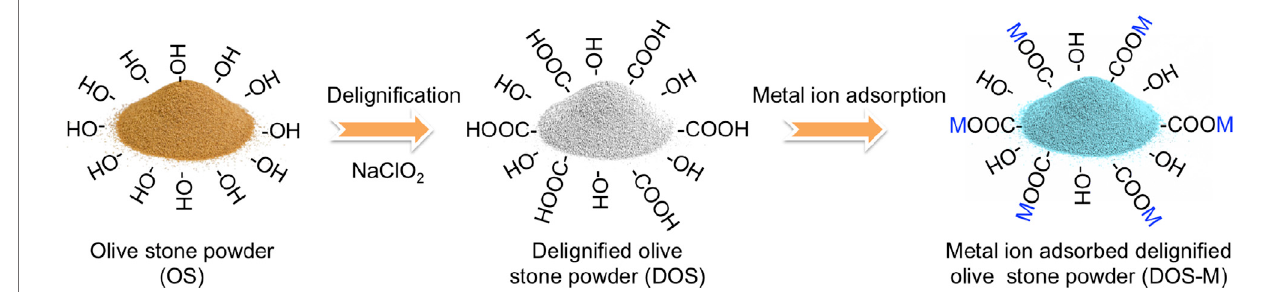
FIGURE 1 | Schematic showing olive stone deligni fi cation and the metal ion adsorption process. M represents metal